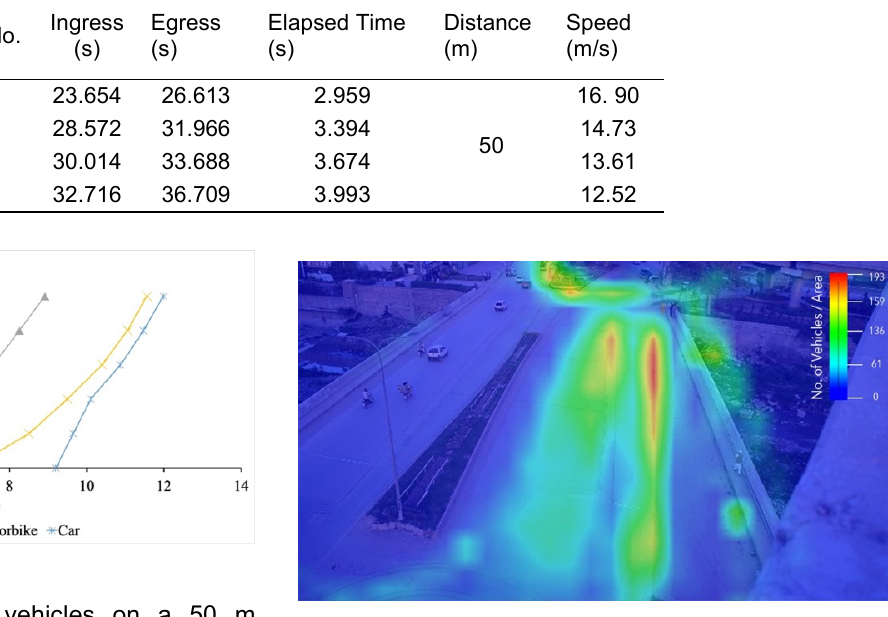
Figure 9. Trajectories for 5 vehicles on a 50 m University Road section.